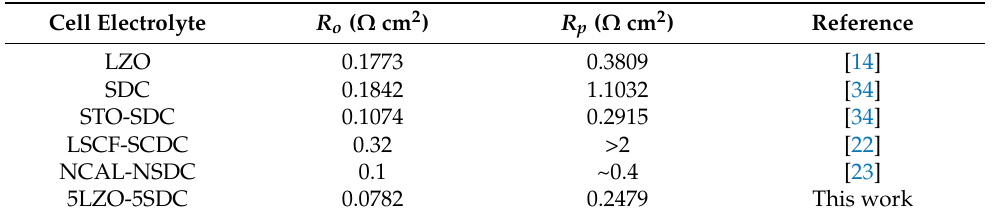
Table 2. The comparison of 5LZO-5SDC fuel cell with previously reported fuel cells using the same NCAL-Ni electrodes at 550 ◦ C in terms of R o and R p